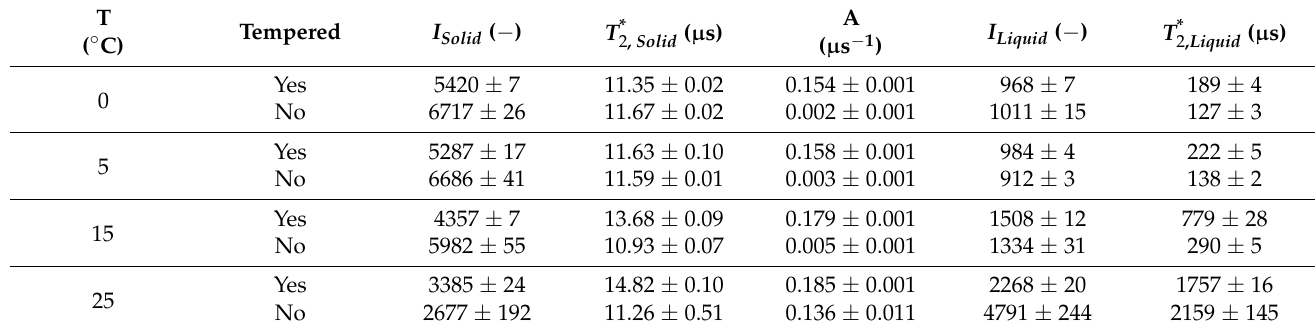
Table A1. Estimated parameter values of the fit of the Adam-Berret model to the experimentally determined FID profiles of tempered and non-tempered cocoa butter at 0, 5, 15 and 25 ◦